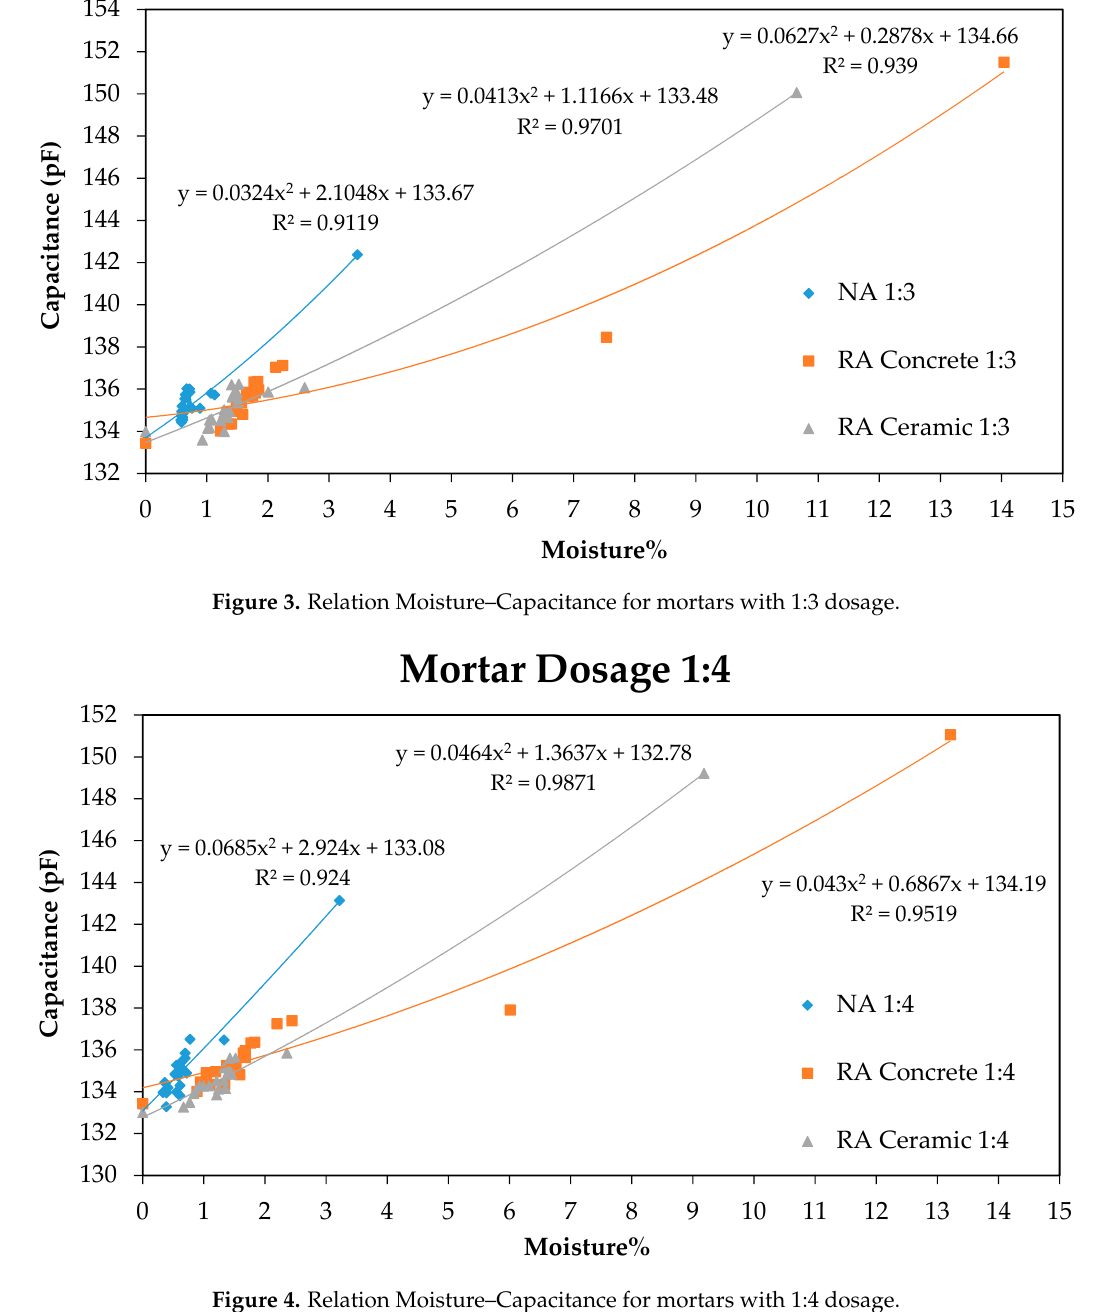
Figure 4. Relation Moisture–Capacitance for mortars with 1:4 Figure 4 . Relation Moisture–Capacitance for mortars with 1:4 dosage .